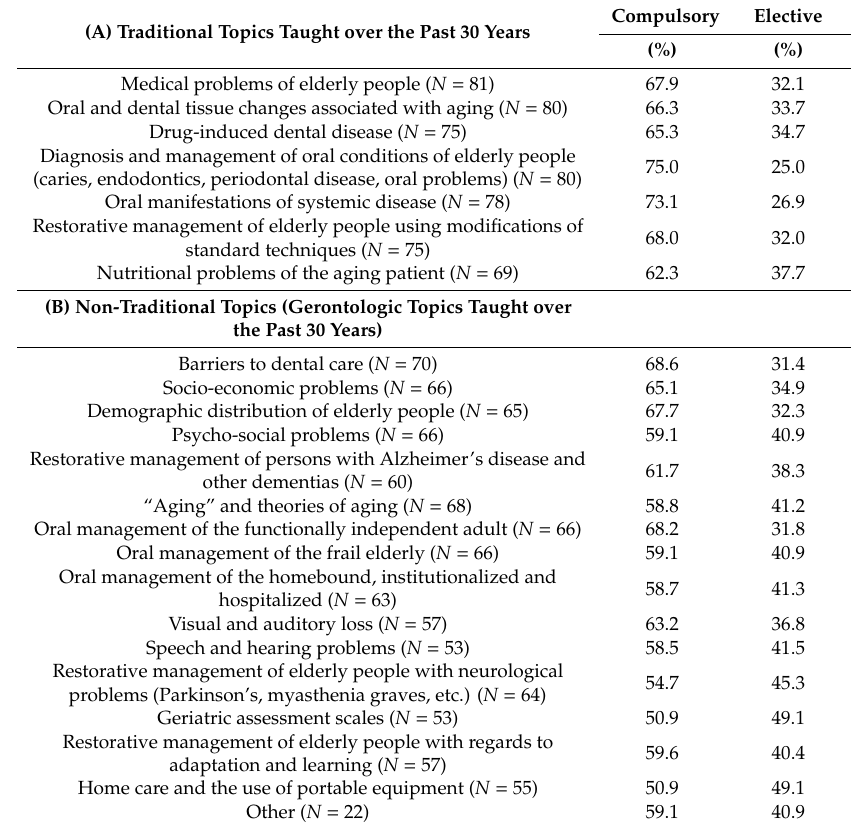
Table 5. Topics covered by lectures and seminars in undergraduate programs: (A) traditional topics (oral medicine / prosthodontics) and (B) non-traditional topics (gerontological).